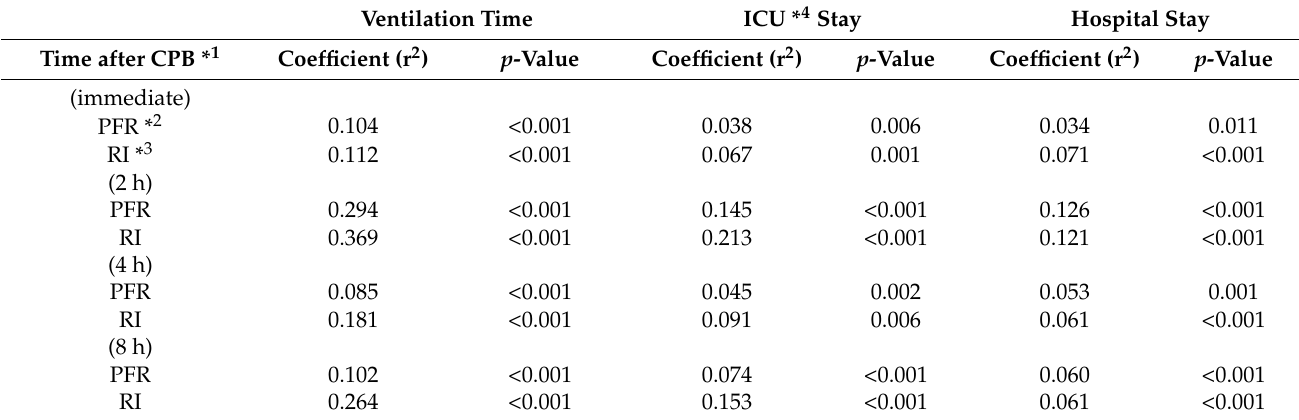
Table 3. Correlations between postoperative pulmonary function and clinical outcomes.